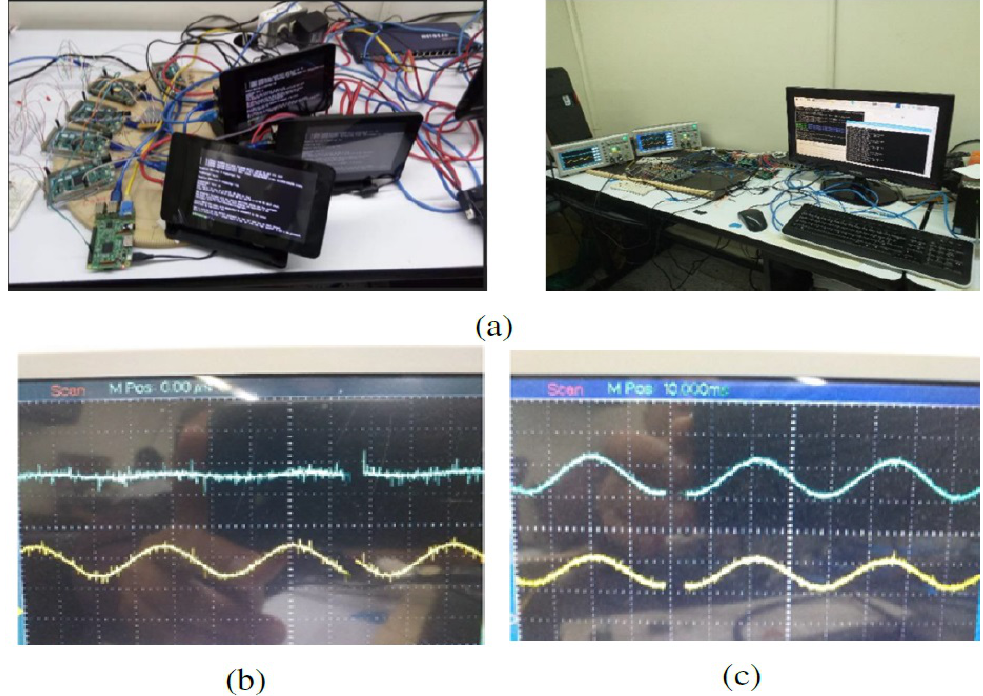
Figure 10. Microgrid emulation: ( a ) node integration, ( b ) top: biodiesel current, below: diesel current, ( c ) top: photovoltaic current, below: load